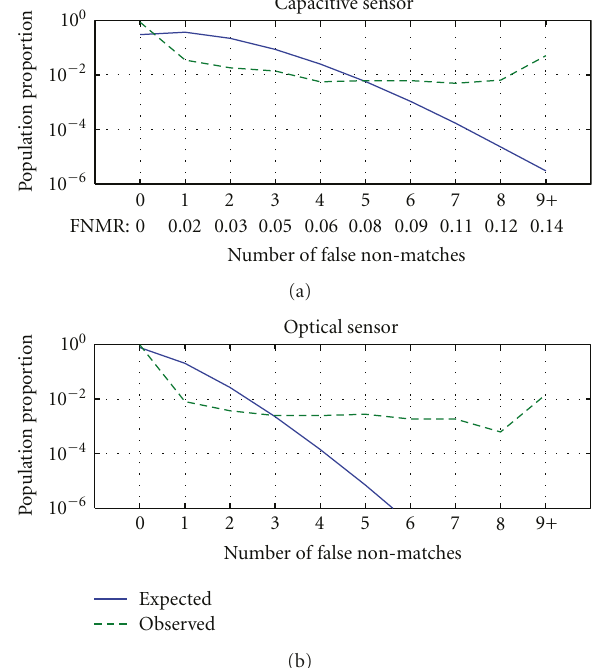
Figure 2: Distribution of the expected (solid lines) and observed (dashed lines) number of false nonmatches across subjects and fingers for the capacitive sensor (a) and the optical sensor (b). The numbers in between panels represent the corresponding false nonmatch rates.